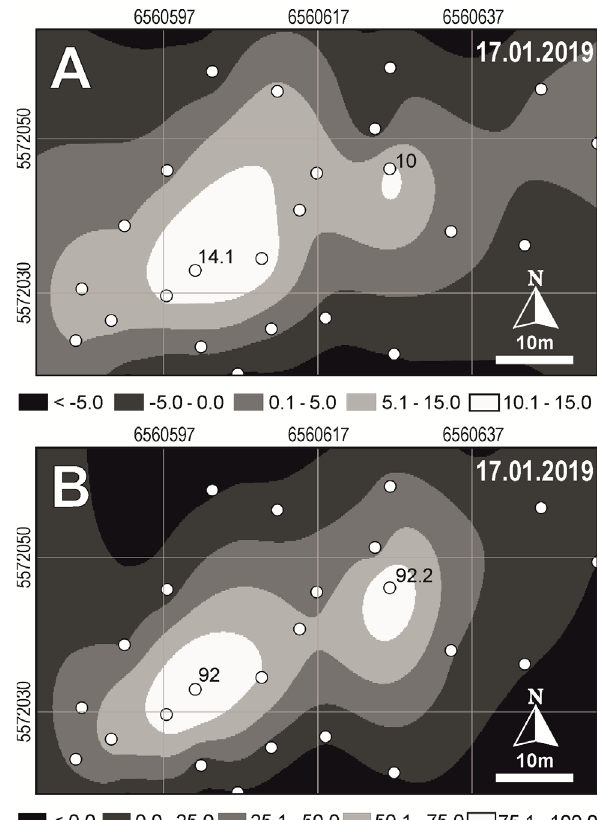
Figure 2. Thermal maps prepared on the basis of pyrometric measurements: A – surface temperature [ o C]; B - the temperature at a depth of 30 cm [ o